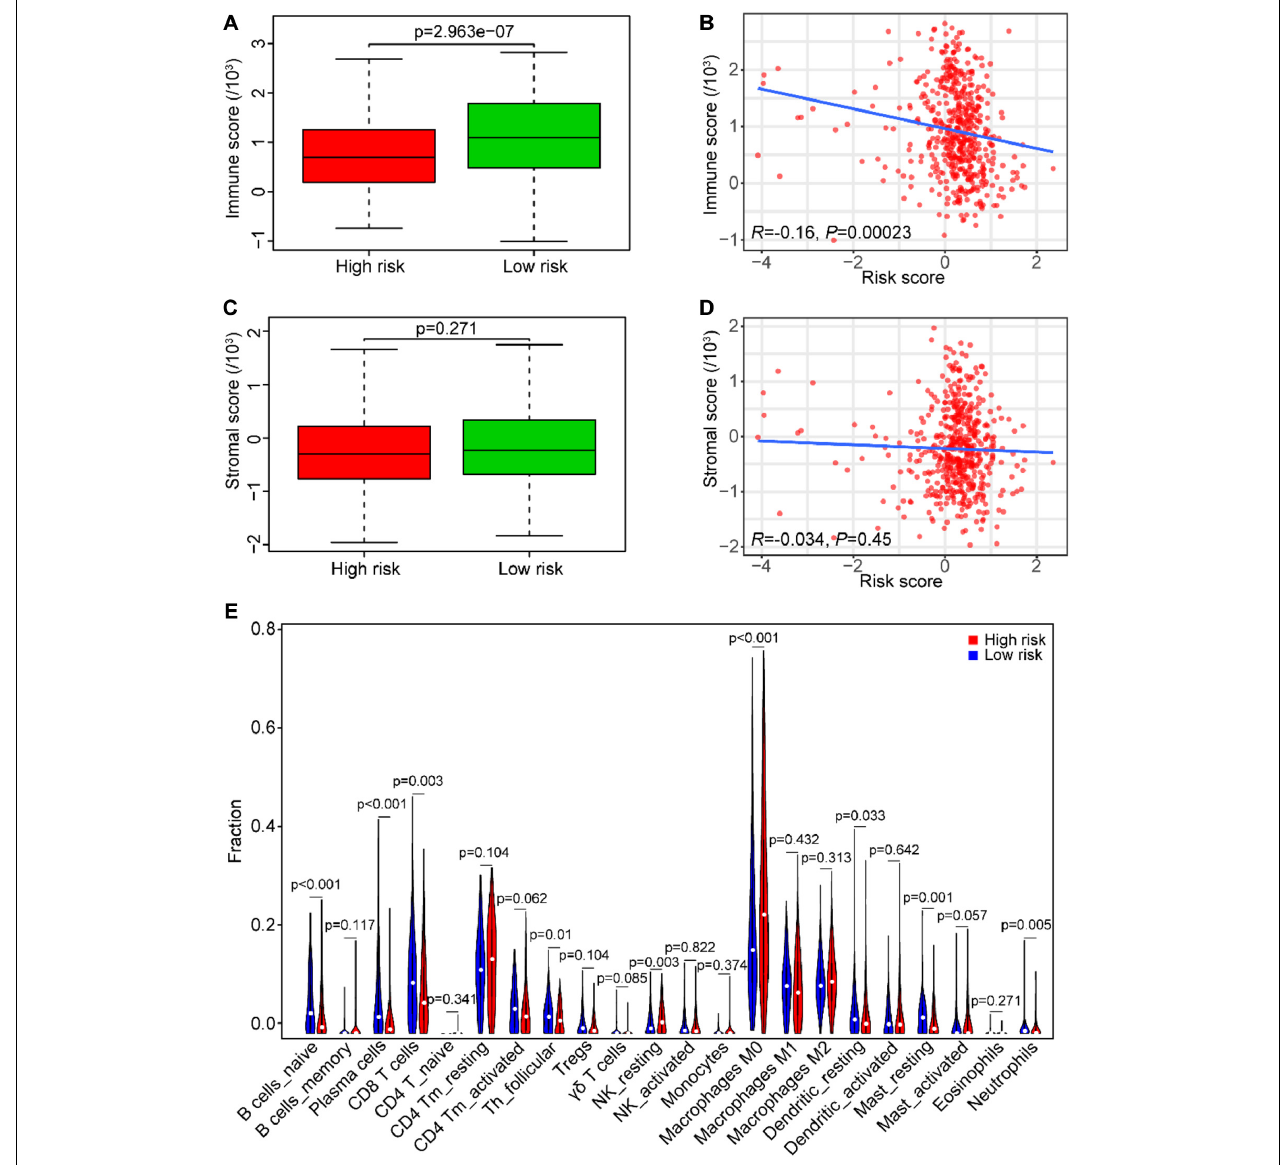
FIGURE 9 | Association between the risk score and tumor immunity in the TCGA data set. (A) The immune score distribution in risk subgroups of SCCHN patients. (B) Correlation of the risk score with the immune score in SCCHN samples. (C) The stromal score distribution in risk subgroups of SCCHN patients. (D) Correlation of the risk score with the stromal score in SCCHN samples. (E) Comparison fractions of immune cells between the high-risk and low-risk